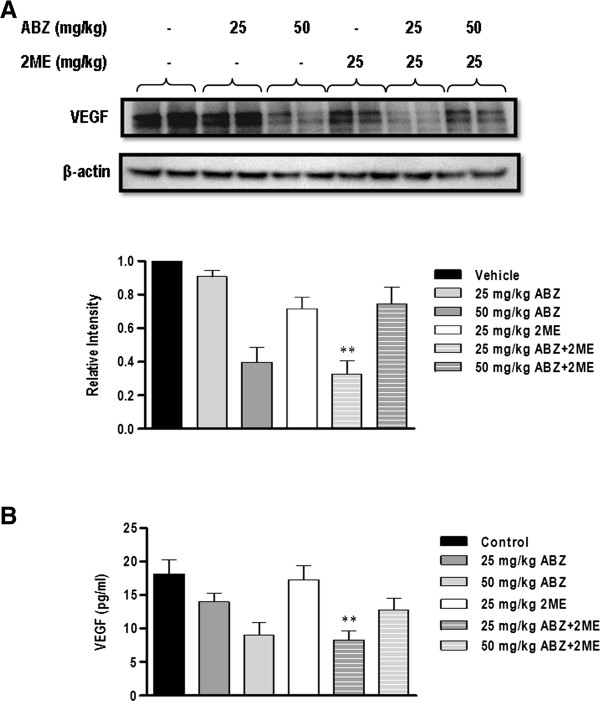
Effect of ABZ, 2ME and combination on VEGF levels in tumor and plasma sample. A, Four tumors from each treatment group were analyzed for VEGF levels and the blot is representative of four samples. β-actin was used as a control for equal protein loading. Graph shows densitometric analysis of VEGF immunoblot and each column represents the mean ± SEM. B, Following euthanasia, blood was collected by cardiac puncture and plasma samples were subjected to ELISA assay for VEGF levels. Each column represents mean VEGF levels ± SEM (n = 8–9). (**P < 0.001 compared with single agents).